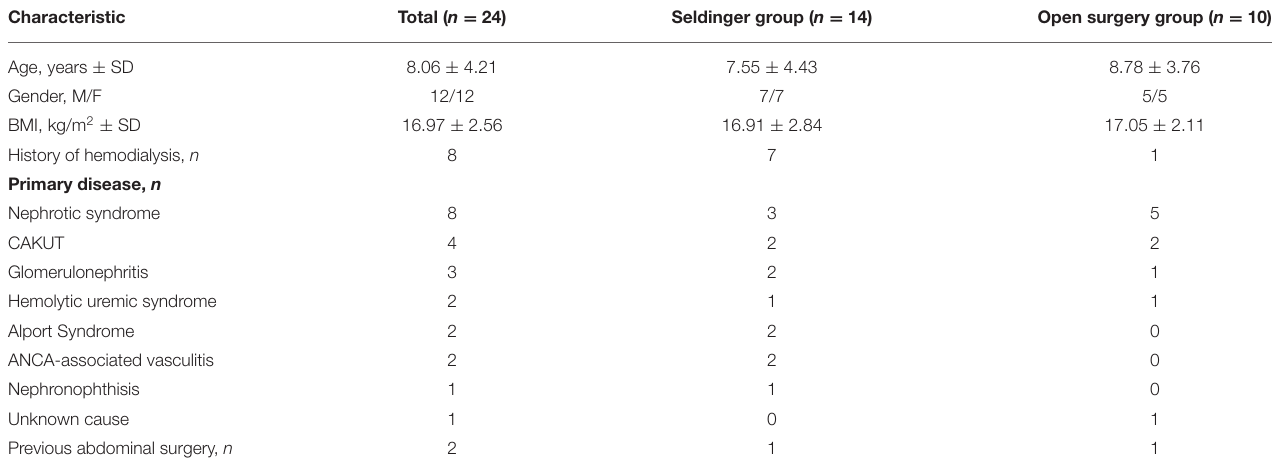
TABLE 1 | Characteristics of patients in the two